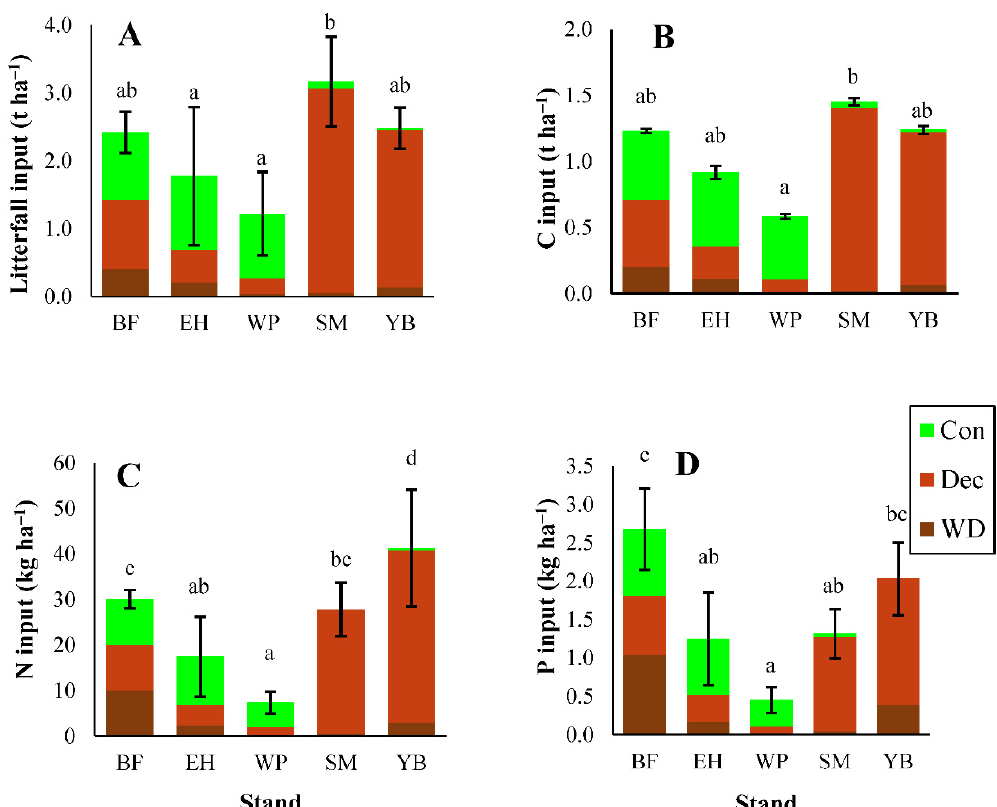
Figure 1. Litterfall mass ( A ) and inputs of carbon (C) ( B ), nitrogen (N) ( C ), and phosphorus (P) ( D ) in coniferous needles (Con), deciduous leaf litter (Dec), and woody debris (WD). BF = Balsam Fir, EH = Eastern Hemlock, WP = White Pine, SM = Sugar Maple, YB = Yellow Birch. Different letters represent significant differences ( p < 0.05) in total litterfall inputs among stands. ANOVA test results shown in Tables S2 and S3. Error bars indicate standard error (S. E.). For BF, EH, and YB, n = 3. For SM and WP, n = 5.